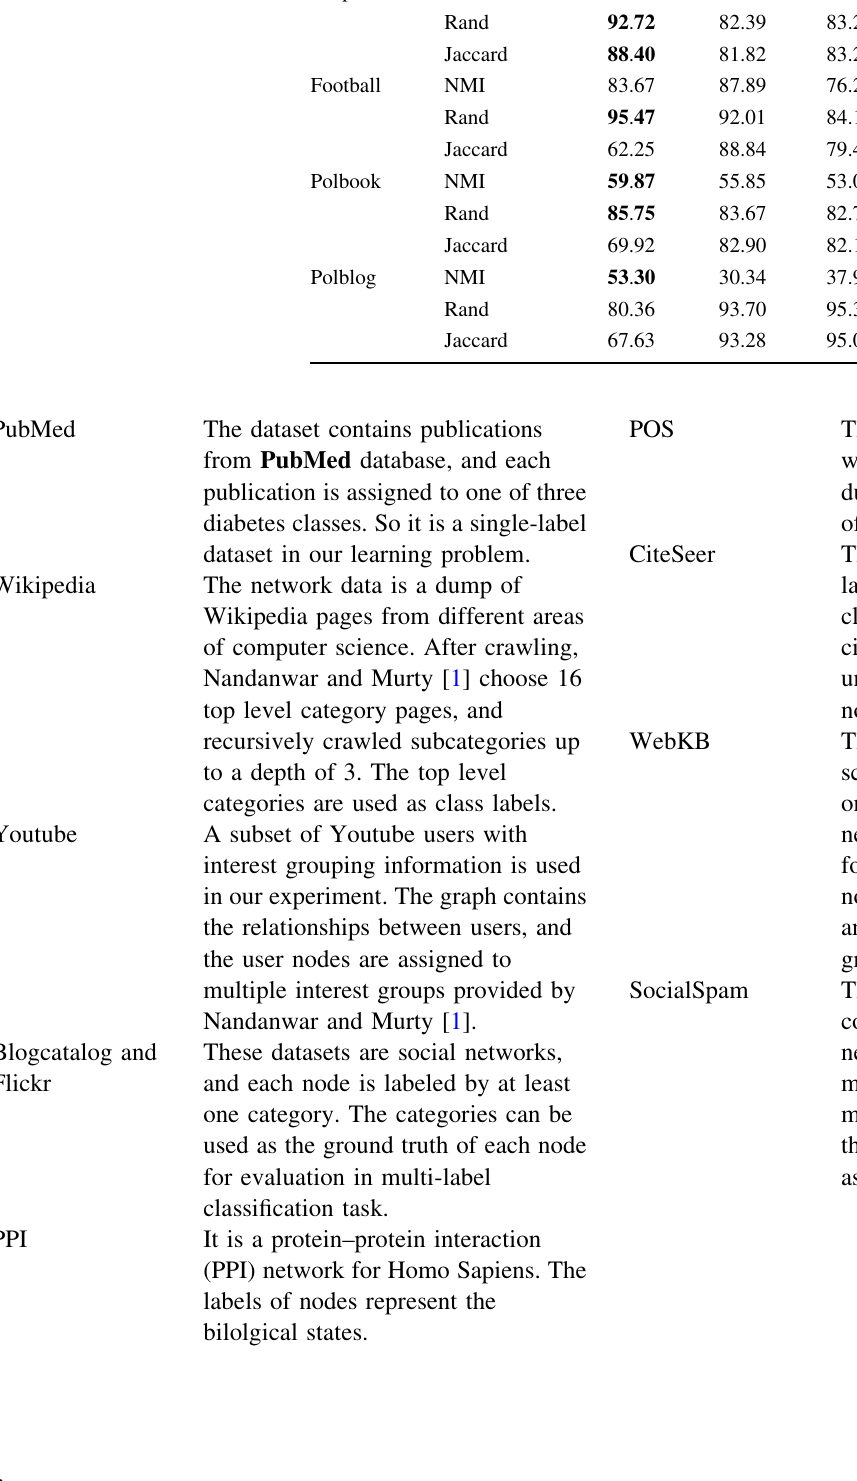
Table 1 Experiment comparisons between IDRN (with 10% labeled nodes for training) and other unsupervised community detection algorithms by the metrics of NMI, Rand index and Jaccard